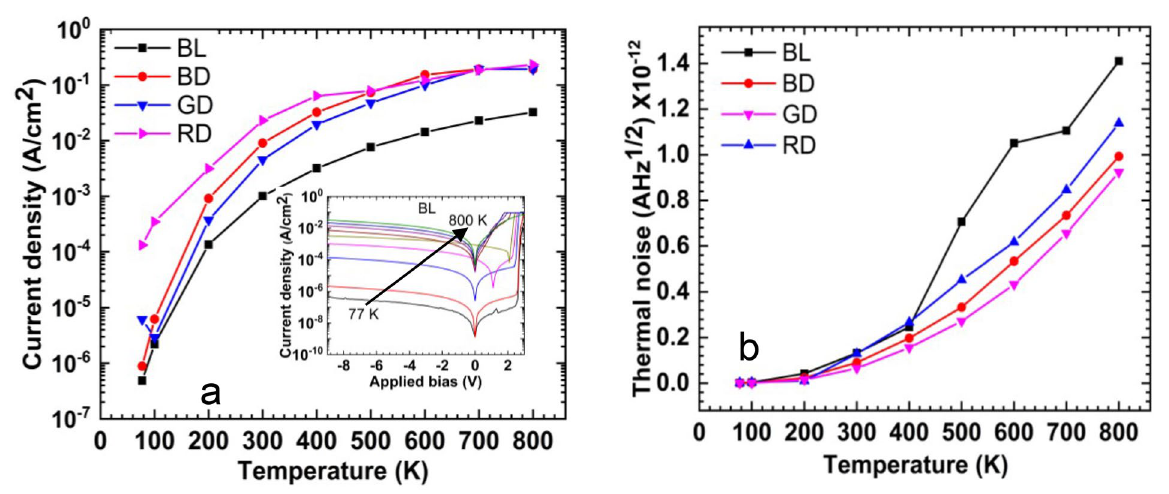
Figure 3. ( a ) Temperature-dependent leakage current density of blue for lighting and display, green for display, and red for display at − 9 V bias voltage (except red for display at − 7 V). Inset: Typical temperature-dependent I–V characteristics of blue for lighting. ( b ) Temperature-dependent thermal noise of